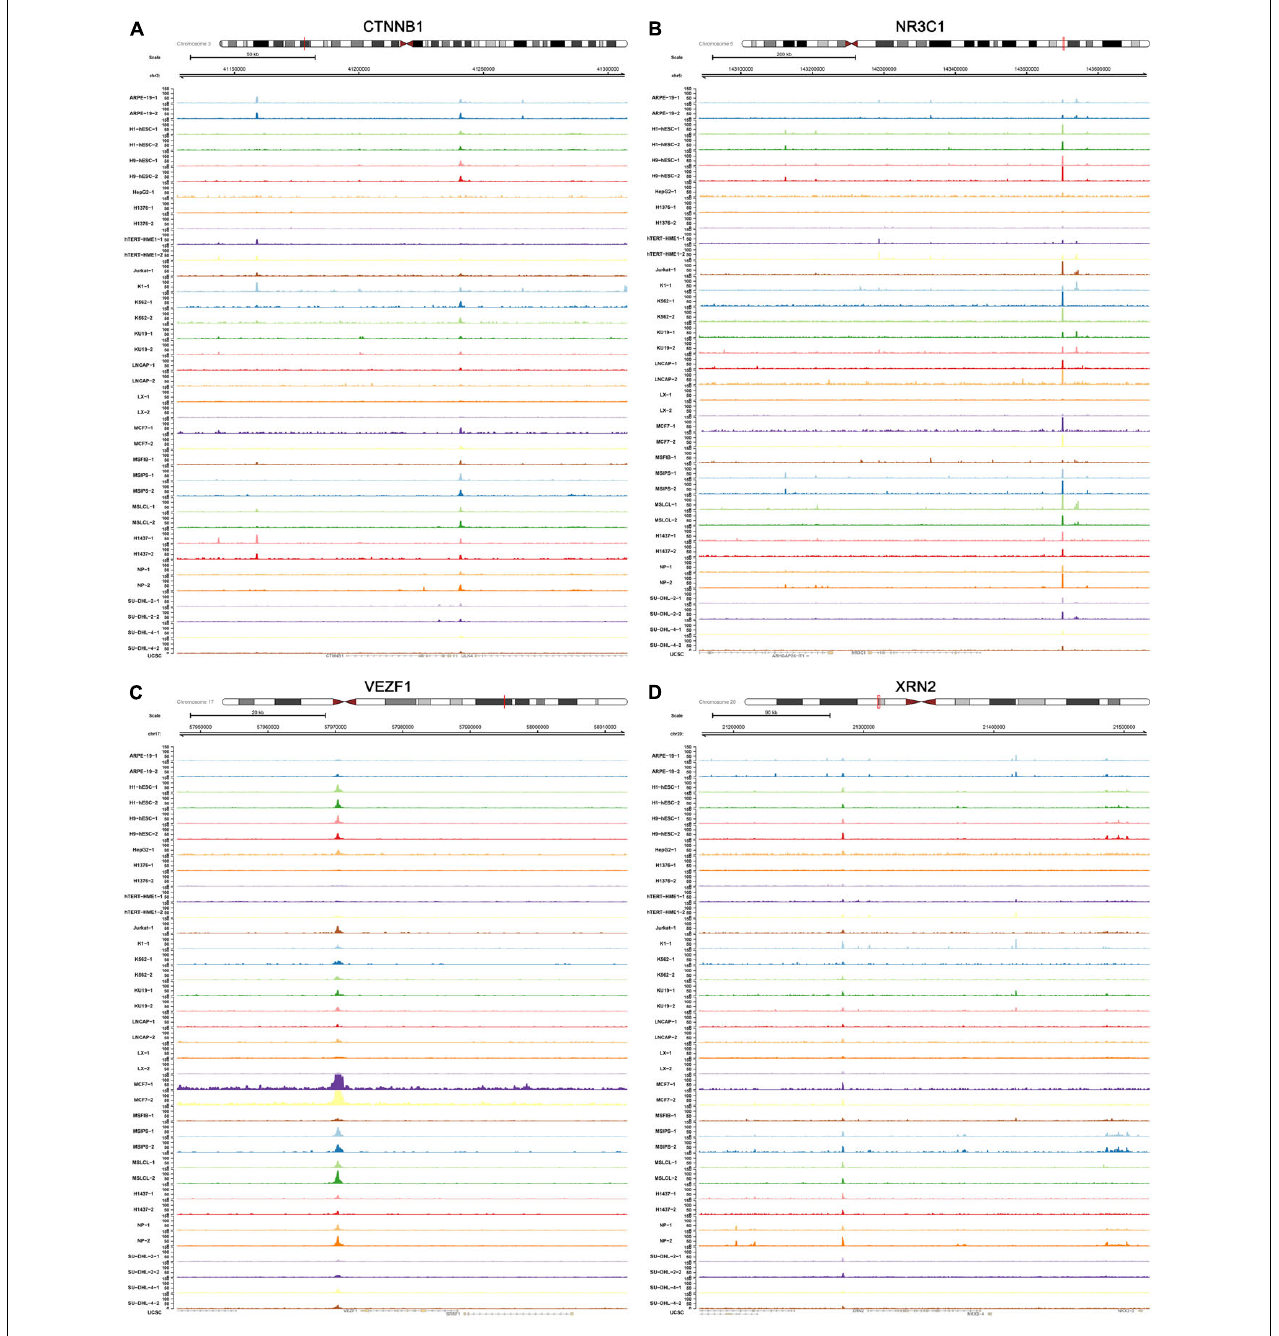
FIGURE 8 | Validation of four key TFs (CTNNB1, NR3C1, VEZF1, and XRN2) in ATAC-seq data available from GSE139099. Binding peaks of three key four key TFs [CTNNB1 (A) , NR3C1 (B) , VEZF1 (C) , and XRN2 (D) ] in ATAC-seq data of 24 different cell lines from a variety of tissues were visualized by Gviz.